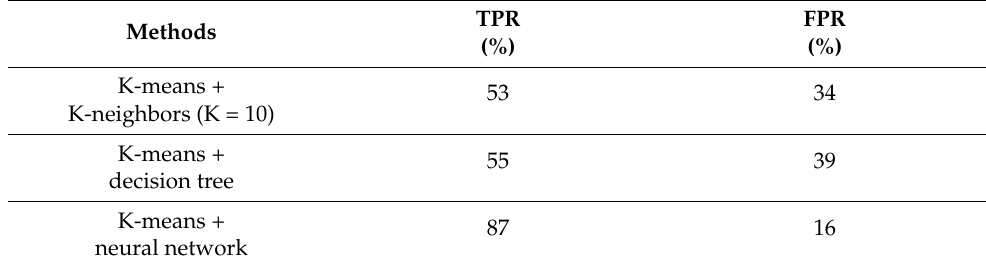
Table 11. Results of combining K-means with a supervised